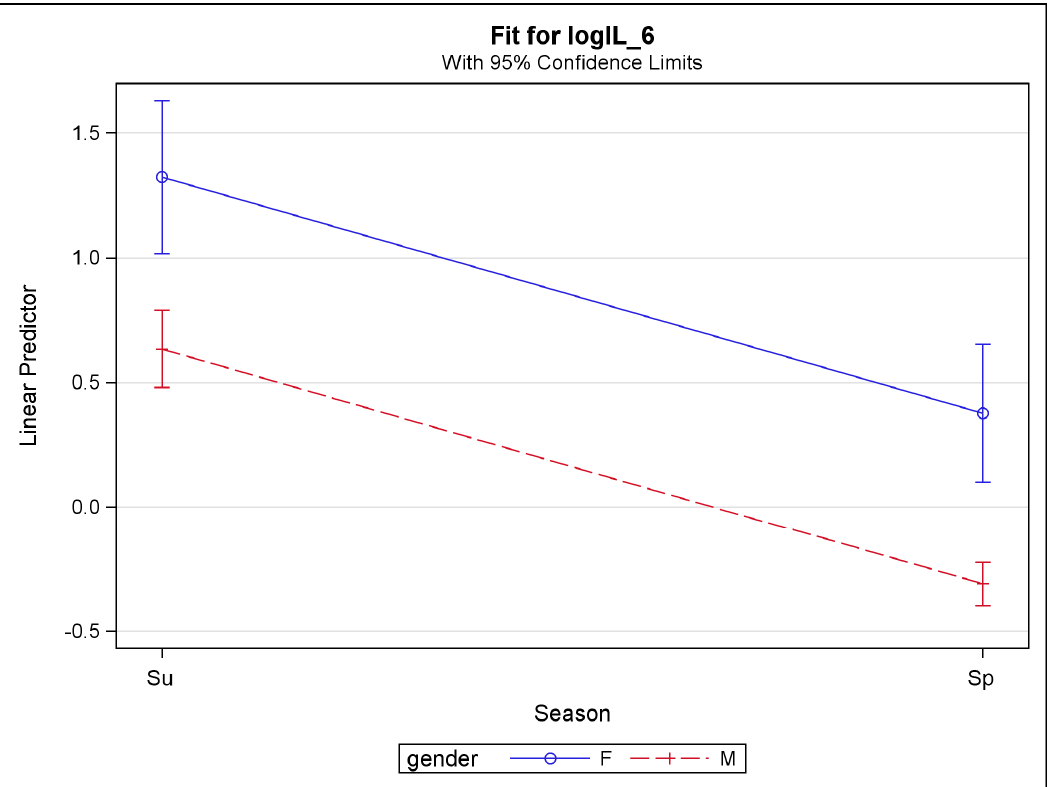
Figure 2. Predicted log (IL-6) concentration (with confidence intervals) versus season (Su: summer; Sp: spring) and gender (F: female; M: male).